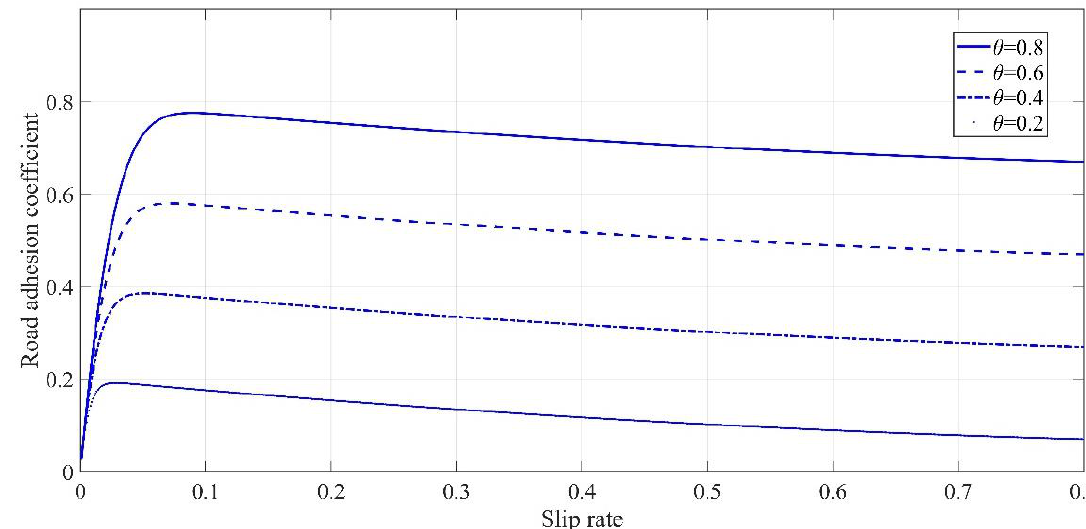
Figure 8. Relationship between the road adhesion coefficient curve and 𝜃 .